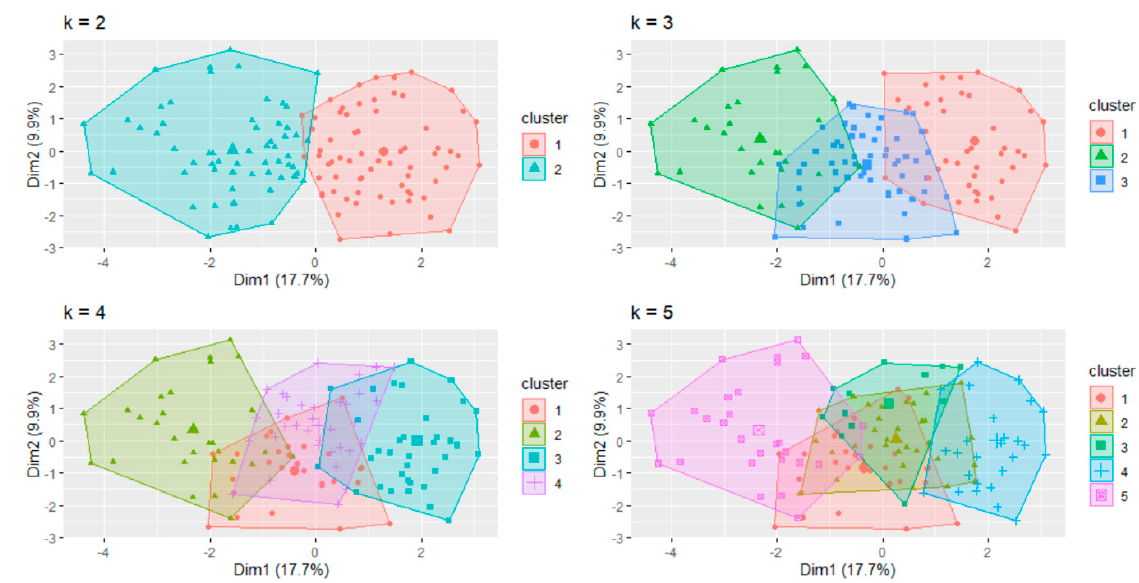
Figure 5. Students’ clusters by k means ( k = 2, 3, 4, 5). Task 5. Determine the attitude of students towards distance learning.